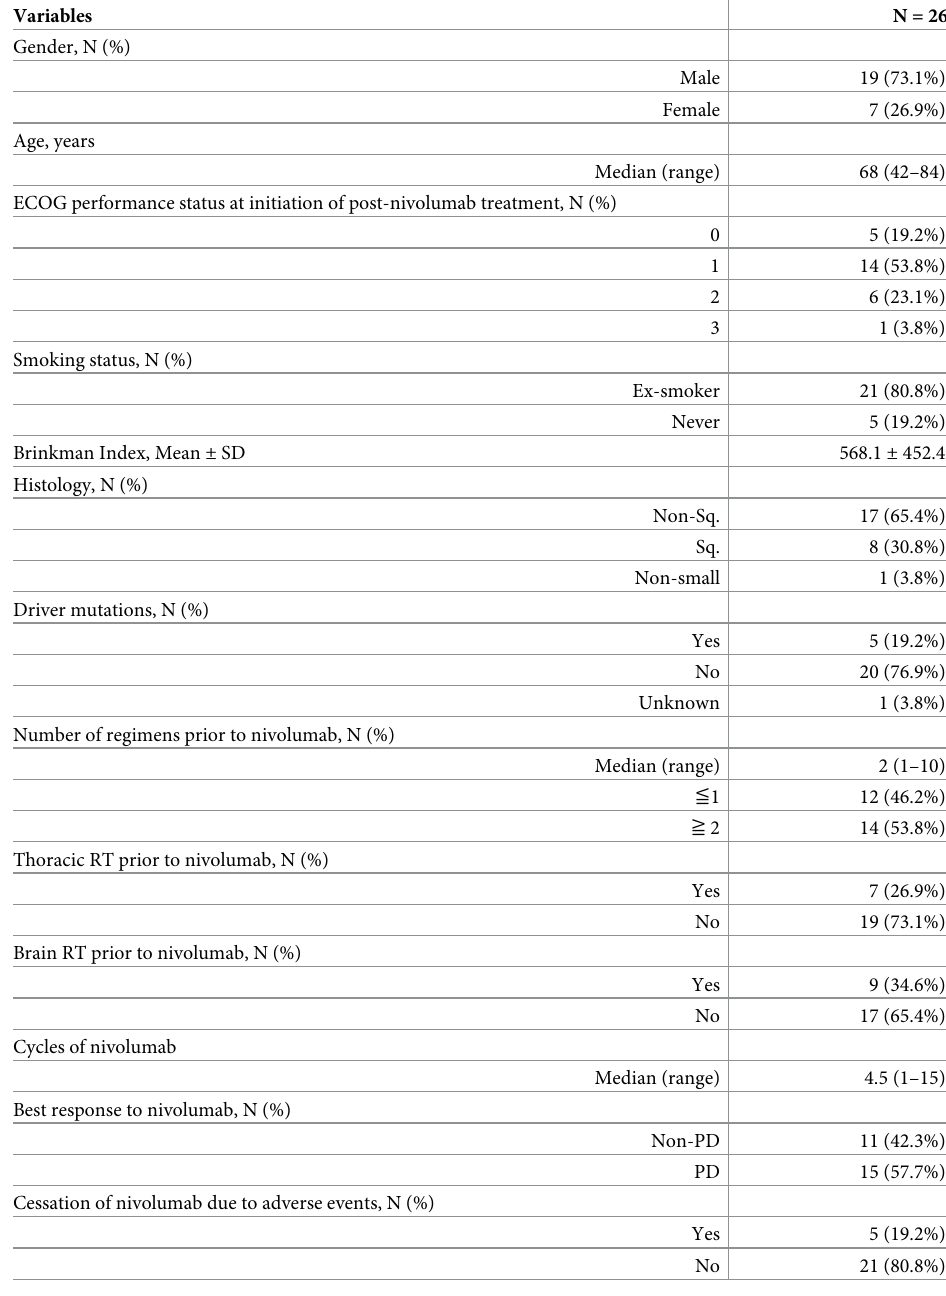
Table 1. Patient